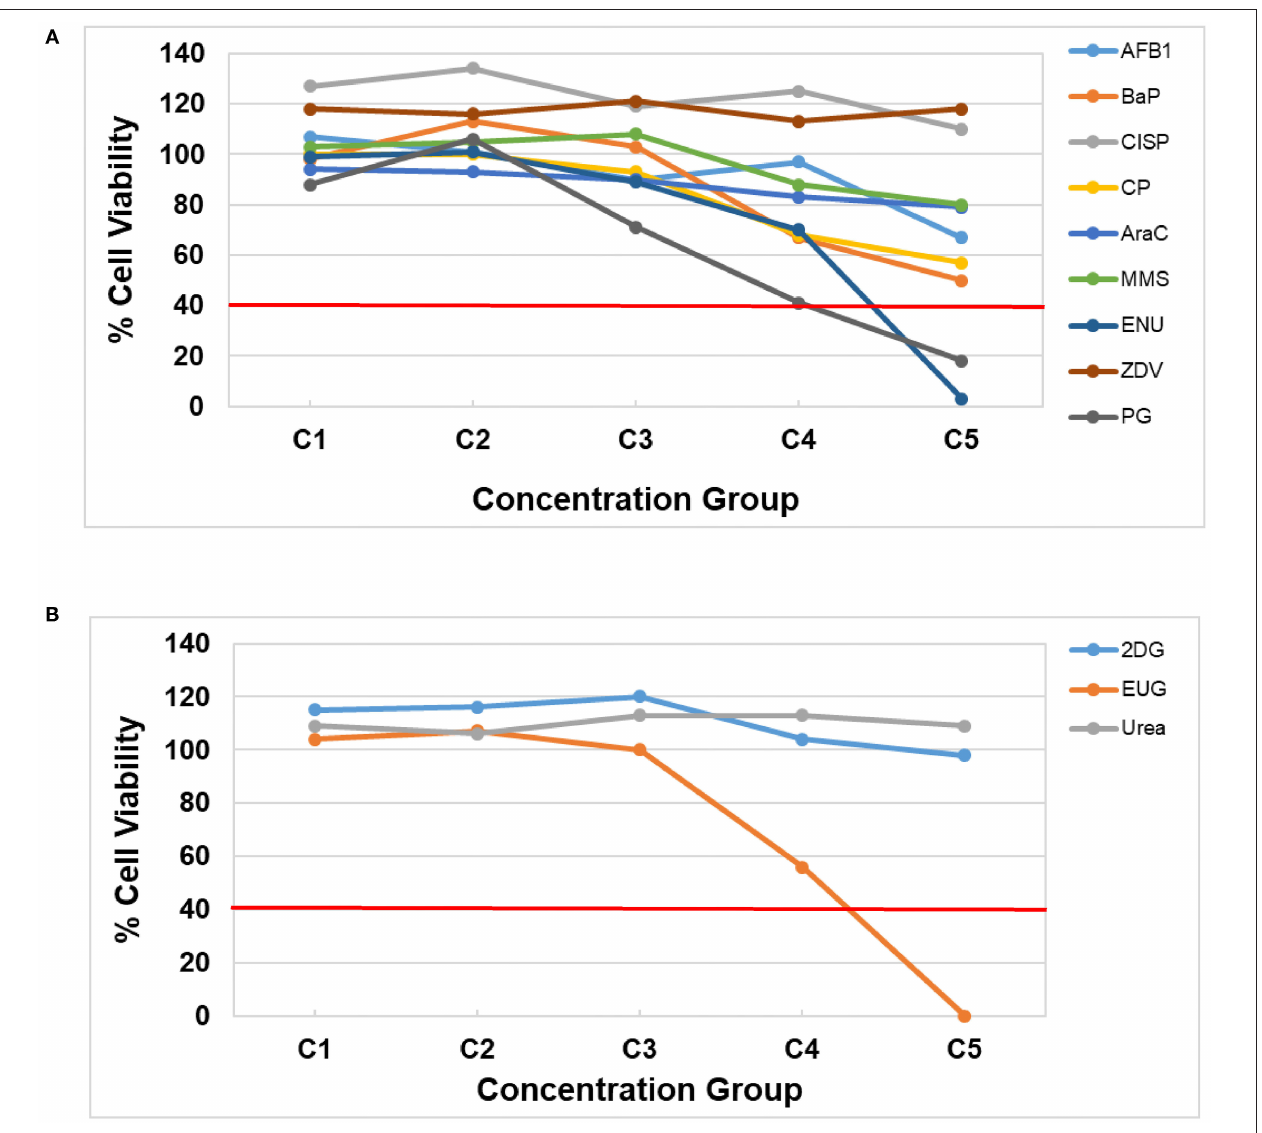
FIGURE 1 | HepaRG TM cell viability measured using the CellTiter-Glo ® Luminescent Cell Viability Assay for (A) DDI (Group 1) chemicals and (B) non-DDI (Group 2 and 3) chemicals. DDI chemical abbreviations: aflatoxin B1 (AFB1), benzo[a]pyrene (BaP), cisplatin (CISP), cyclophosphamide (CP), cytosine arabinoside (AraC), methyl methanesulfonate (MMS), N-ethyl-N-nitrosourea (ENU), zidovudine (ZVD), and propyl gallate (PG; included with Group 1 chemicals). Non-DDI chemical abbreviations: 2-deoxy-D-glucose (2DG), eugenol (EUG), and Urea. The test concentrations for each chemical are shown in Table 2 (C1 is the lowest concentration and C5 is the highest concentration). The red line represents the cytotoxicity threshold of < 40% cell